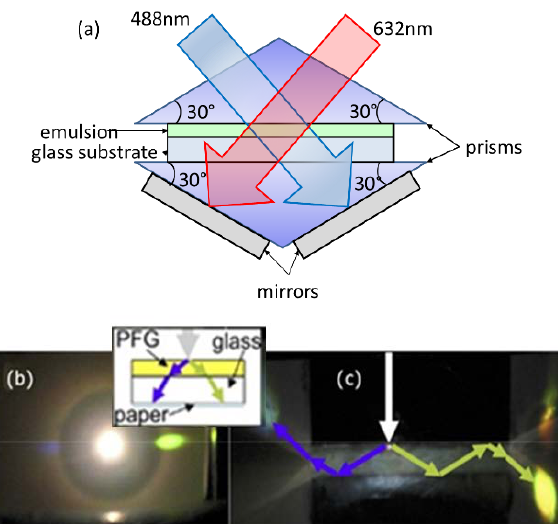
Figure 3. ( a ) A schematic representation of the experimental set-up used in Reference [52] for the doubly slanted layer structure. Red and blue arrows are the incident laser sources emitting at 632 nm and 488 nm, respectively, used to record the double superimposed slanted reflecting hologram. Diffraction patterns evaluated taken from behind ( b ) and above ( c ). Here, the arrow represents the incident light.